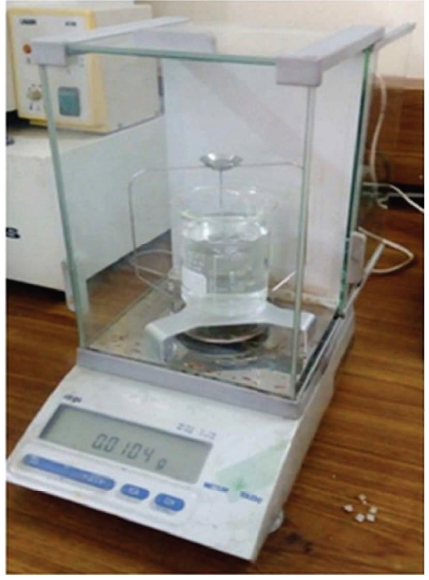
Figure 5: Mettler Toledo electronic balance for density measurement.